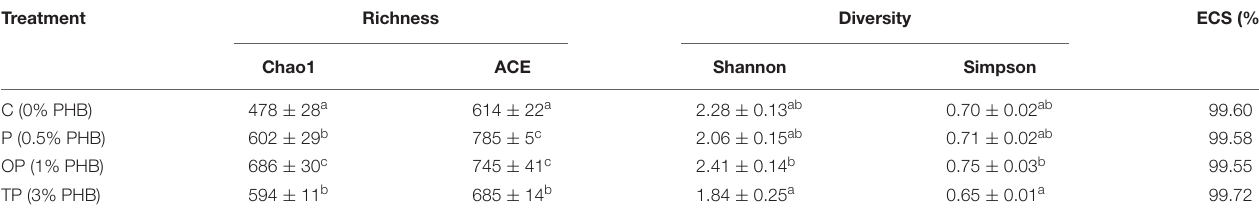
TABLE 3 | Effects of diet supplementation with different levels of PHB on the alpha diversity index of intestinal microbiota for sea cucumbers. Treatment